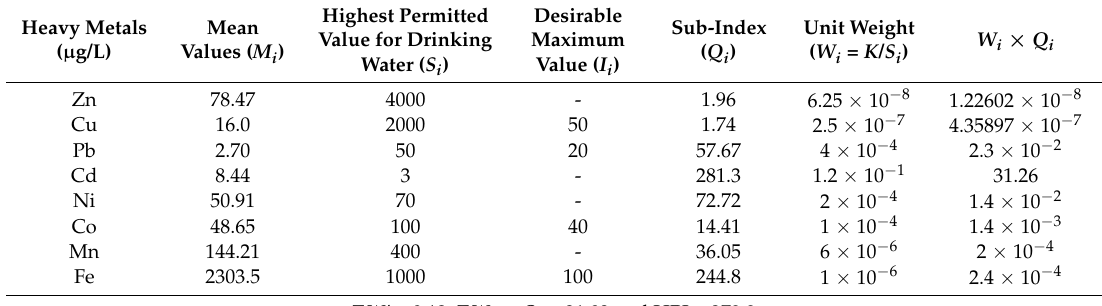
Table 2. HPI calculations for the Syr Darya River following the WHO (2011) guidelines for drinking water. Heavy Metals ( µ